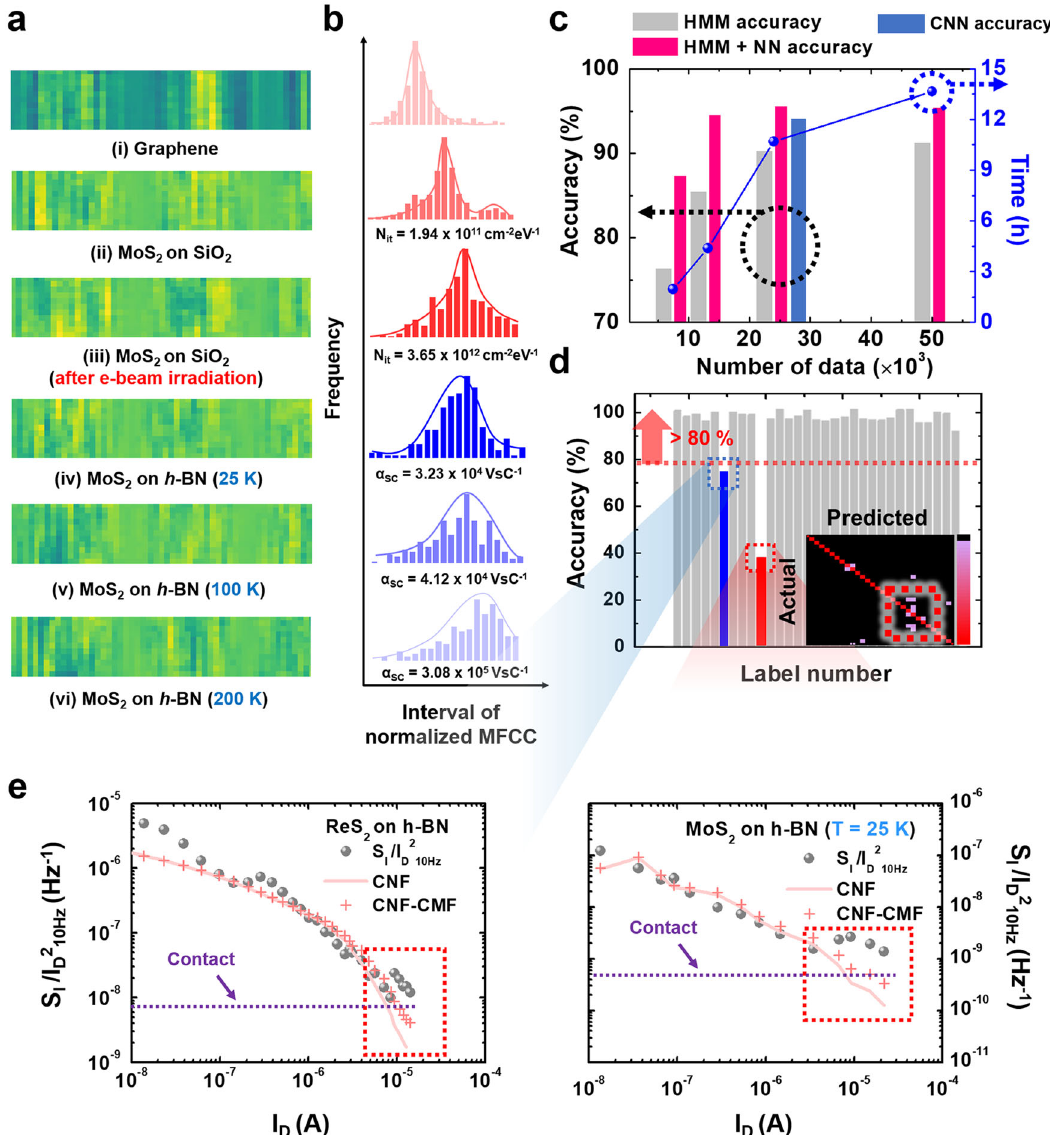
Fig. 4 Engineered current MFCC study and classi fi cation accuracy. a LF part of current MFCC (the darker color, the smaller value) converted at the same I D ≈ 1 μ A in each class ((i) graphene on trench structure, (ii) MoS 2 on SiO 2 , (iii) MoS 2 on SiO 2 after e-beam irradiation, and MoS 2 on h-BN at (iv) T = 25 K, (v) T = 100 K, and (vi) T = 200 K, respectively); b frequency distribution for a speci fi c interval by normalizing the LF part of current MFCC; c classi fi cation accuracies and processing time obtained using the three learning and classi fi cation methods based on the number of data; d classi fi cation accuracies according to each class (the inset shows a confusion matrix and the darker color, the smaller value); e variations in the measured normalized drain current spectral densities for ReS 2 and MoS 2 on h-BN at f = 10 Hz and data fi tted using the CNF and CNF-CMF algorithm, with N it and α SC . Figure 4c displays the classi fi cation accuracies and processing time obtained using the HMM algorithm and the HMM score vector learning method employing the NN for a number of data. When the number of data was 7800, the HMM classi fi cation accuracy was 76.3% with f1-score and AUC value of <0.78 using fourfold cross-validation (see Supplementary Materials Fig. S3 and Note 3.11) 30,59,60 . The HMM + NN classi fi cation accuracy was 85.2% with f1-score of 0.86, AUC value of 0.83, and processing time of 3 h for each fourfold cross-validation. For 22,100 data points, the HMM + NN classi fi cation accuracy increased to 95.5% with f1- score of 0.93, AUC value of 0.91, and processing time of 11 h for each fourfold cross-validation. However, for 48,800 data points, classi fi ca- tion accuracies exhibited no further improvement, and only the over 90% with f1-score of over 0.86 and AUC value of over 0.84, as processing time increased to 15 h. Moreover, the classi fi cation presented in Fig. 4d. However, two exceptional classes, i.e., ReS 2